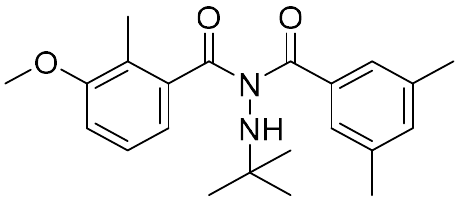
Figure 1. Chemical structure of methoxyfenozide.